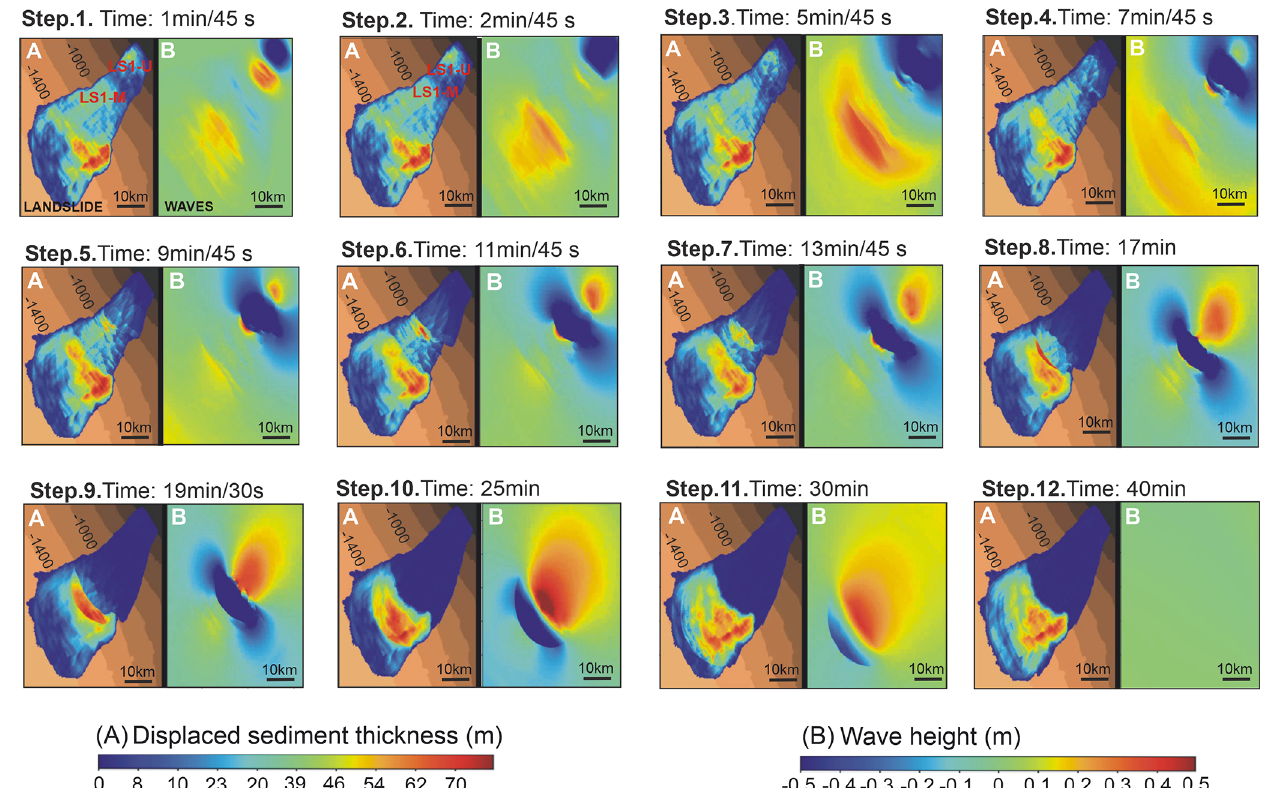
Figure 7. Main composition in 12 consecutive frames. (a) Evolution of the landslide, where two sliding sediment masses in the firsts 25min can be distinguished, one in the upper slope (LS1-U) and the other one in the mid slope (LS1-M), which are merged into a unique one after 25min. The colour scale corresponds to available sediment thickness to be displaced in metres. (b) Dipole wave evolution of the outgoing tsunami with the wave height